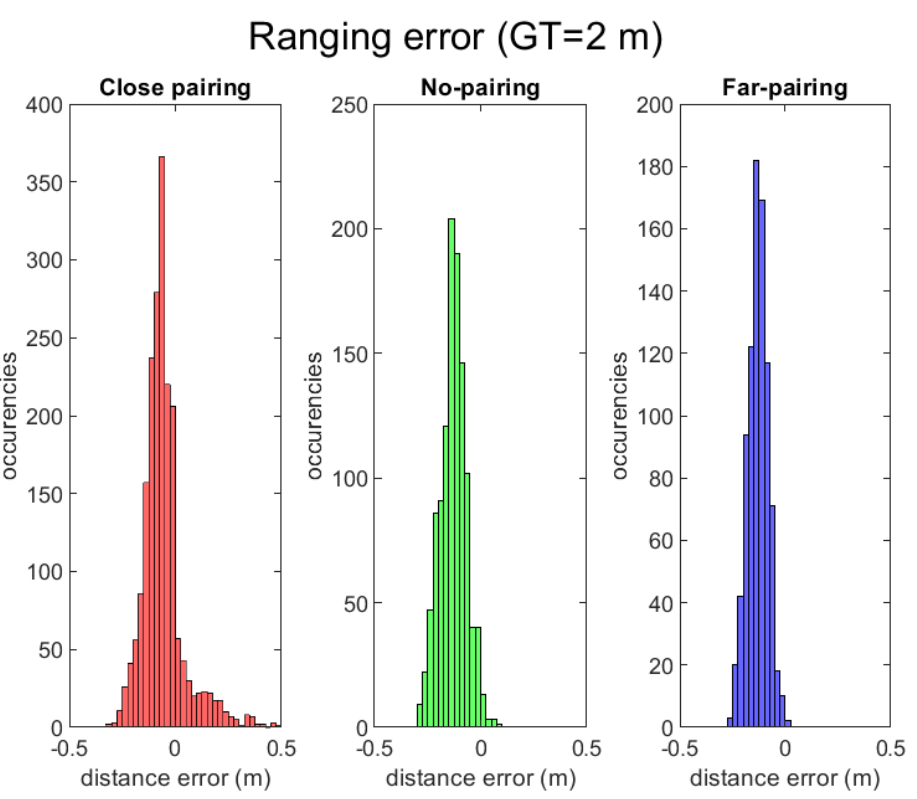
Figure 8. Ranging measurements at 2 m distance from a fixed anchor in LOS conditions. Effect of pairing tags in range errors for: Close pairing (red), No-pairing (green) and Far-pairing